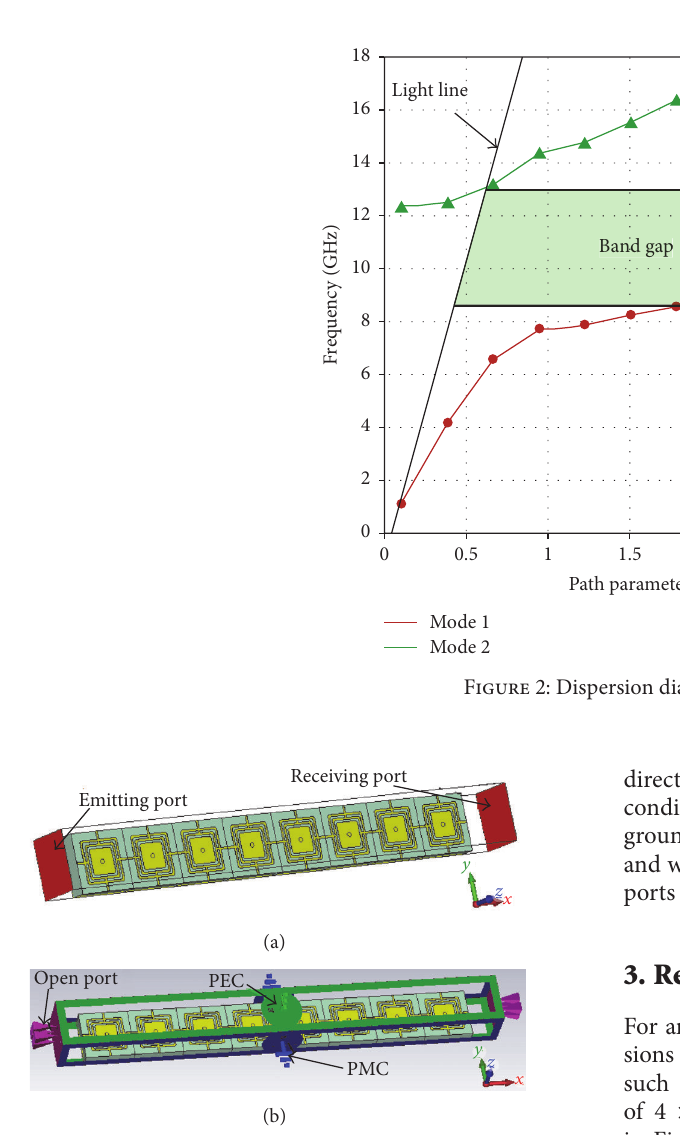
Figure 3: EBG array simulation settings achieved the band gap measurements. (a) EBG characterization principle; (b) waveguide boundary